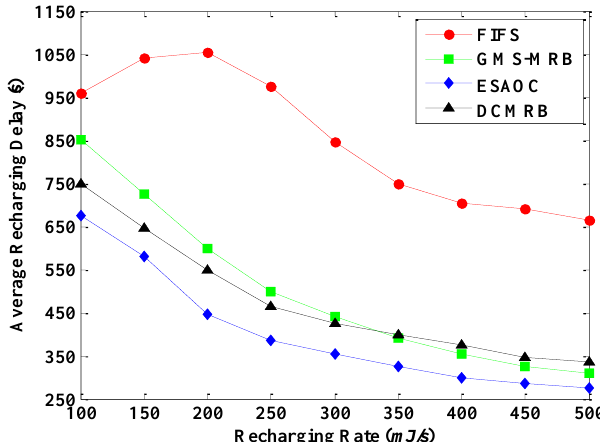
Figure 23. Average recharging delay under different recharging rates.